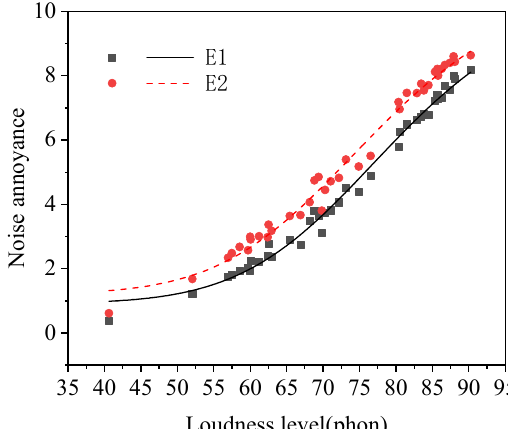
Figure 6. Noise annoyance of two groups of subjects with different incomes (subgroups E1–E2).